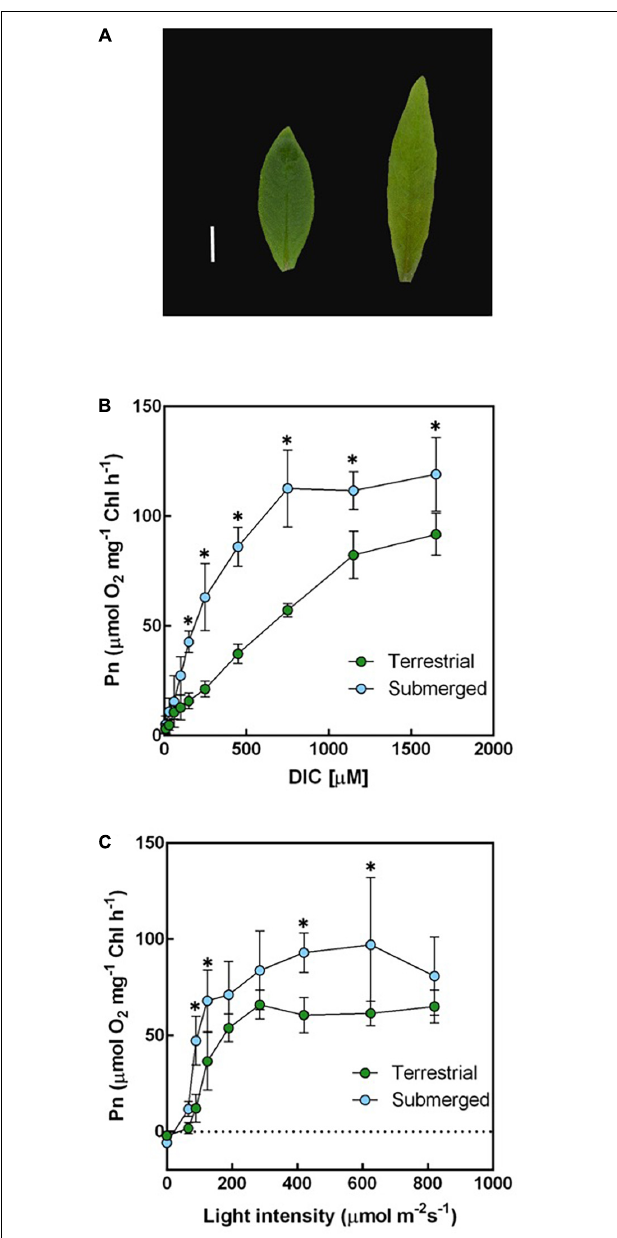
FIGURE 1 | Leaf morphology, dissolved inorganic carbon (DIC), and light-response curves of underwater photosynthesis in terrestrial and submerged leaves of Hygrophila polysperma . (A) Heterophyllous leaves of H. polysperma that developed under terrestrial (left) or submerged environments (right). The scale bar is 10 mm. (B) The DIC response curve for underwater photosynthesis per chlorophyll content in the terrestrial and submerged leaves of H. polysperma ( n = 3). DIC concentration increased from 10 to 1,650 µ M by injected NaHCO 3 . Measurement light intensity was 285 µ mol m − 2 s − 1 , and the pH was 6.3. (C) Light-response curve of underwater photosynthesis per chlorophyll content in the terrestrial and submerged leaves of H. polysperma ( n = 3). Photosynthetic photon flux density increased from 0 to 820 µ mol photons m − 2 s − 1 in the presence of 10 mM NaHCO 3 at pH 6.3. The results shown in panels (B) and (C) are expressed as means ± SD. Significance was analyzed by two-way ANOVA with Hlom–Sidak test ( ∗ p < 0.05).